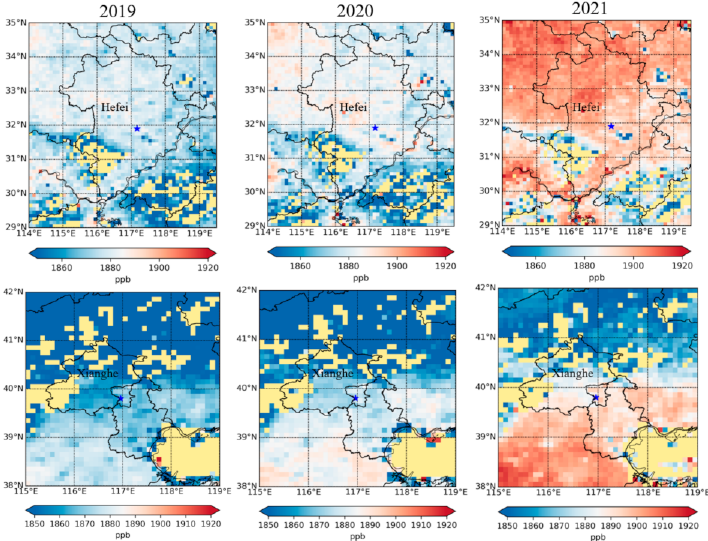
Figure 6. The distributions and variations in the annual means of TROPOMI CH 4 total columns around Hefei and Xianghe from 2019 to